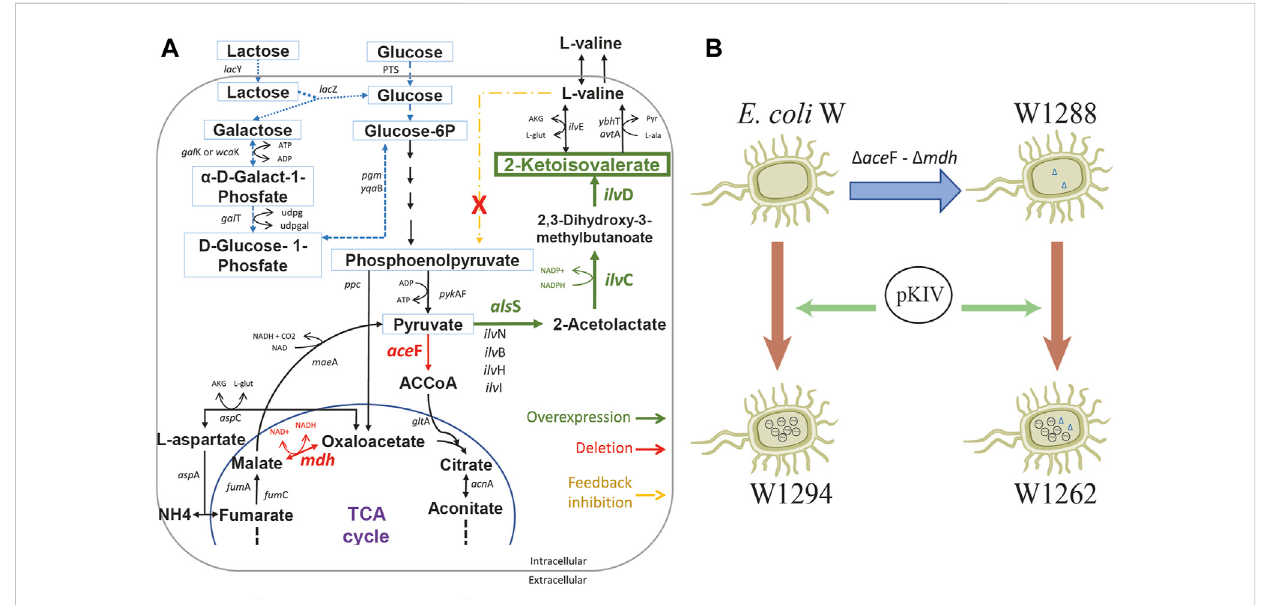
FIGURE 5 Schematic diagram of E. coli W engineering for 2-ketoisovalerate (2-KIV) overproduction. (A) : Main genetic interventions addressed to construct a 2-KIV overproducer E. coli W strain, (B) : Engineering E. coli W strains. Phosphotransferase system (PTS), Glucose-6-phosphate (Glucose-6P),